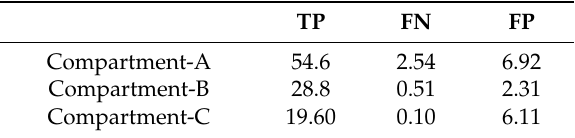
Note: The values of TP, FN, and FP were calculated in